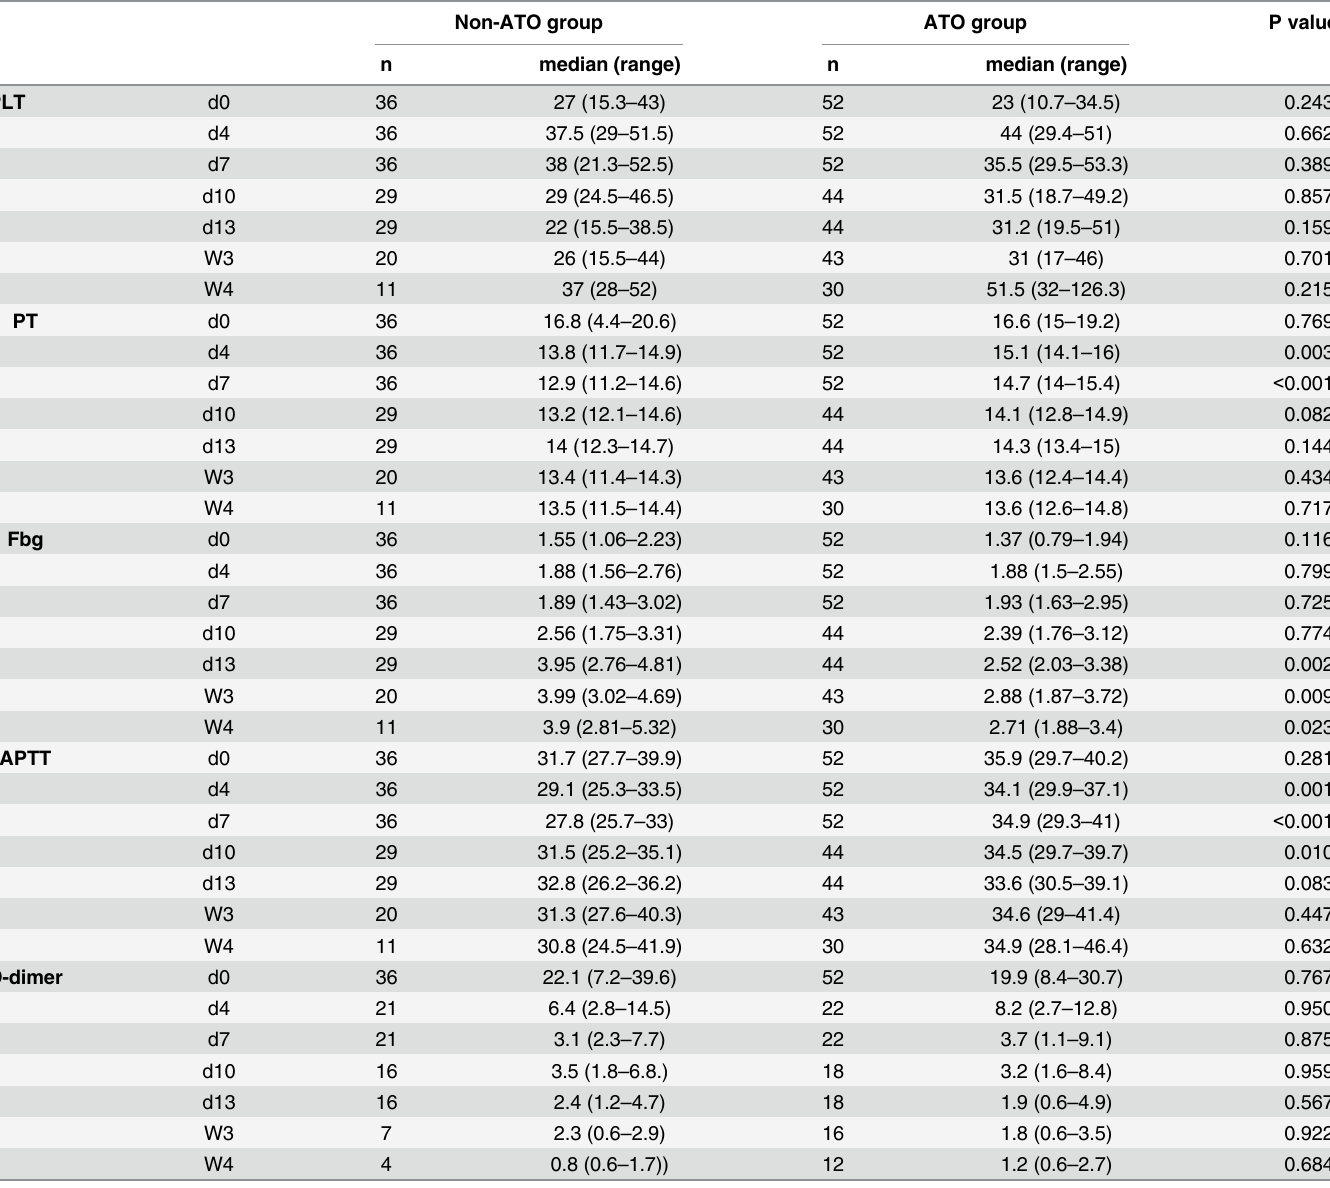
Table 3. Compared analysis of hemostatic parameters between non-ATO group and ATO group. Non-ATO group ATO group P